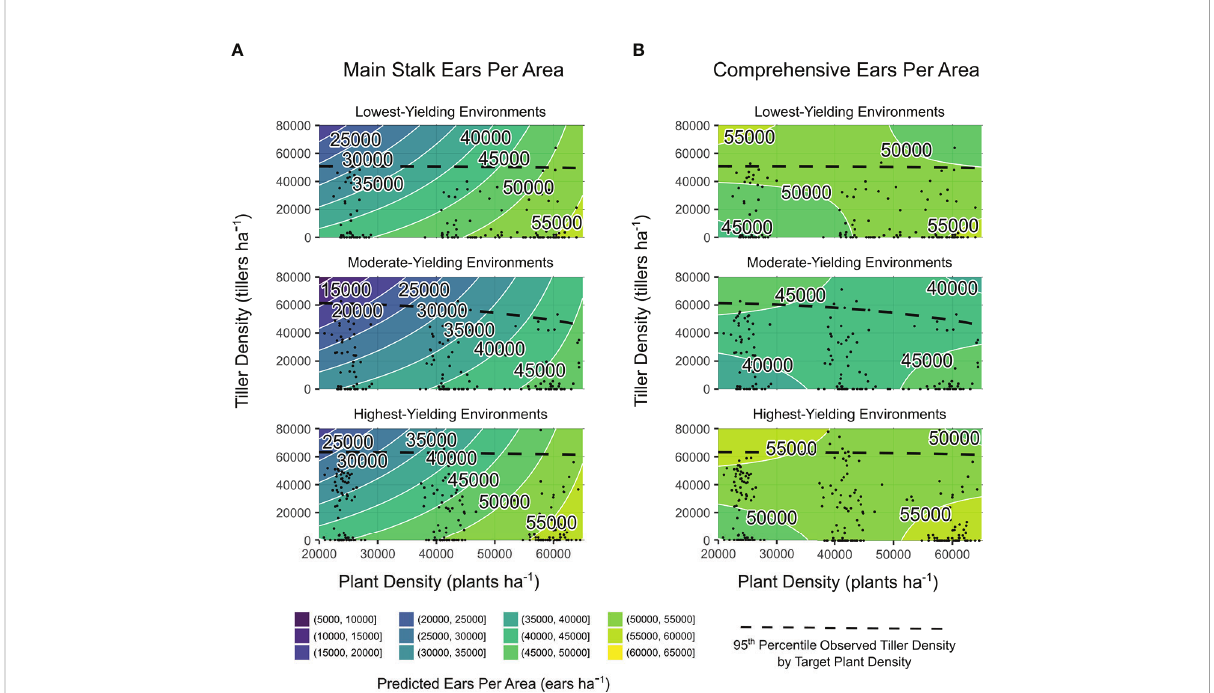
FIGURE 3 Main stalk ears per area (A) and comprehensive ears per area (B) predictions from models of observed plant density, tiller density, and yield environment as determined by analysis shown in Supplementary Table 2. Site-years are grouped by realized yield environment. Contours are shaded and labeled according to 5000 ears ha − 1 density intervals. White lines indicate a change in ear density interval. Observed plant densities and tiller densities are indicated with black points. Black dashed lines are intended as an informal visual indicator of tiller expression potential for each yield environment. Extrapolations beyond black points and dashed black lines are shown for the purpose of comparing environments on the same density